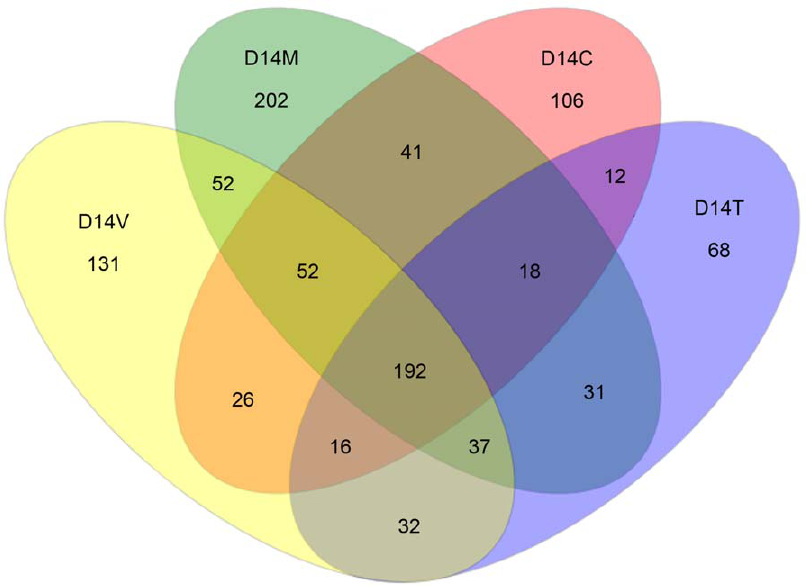
Figure 7. Venn diagram illustrating shared and unique OTUs at day 14 days after the start of treatments. Numbers below groups indicate the number of OTUs within each sector. For each timepoint, C = control diet, M = monensin treatment, V = monensin/virginiamycin treatment, and T = monensin/tylosin treatment.